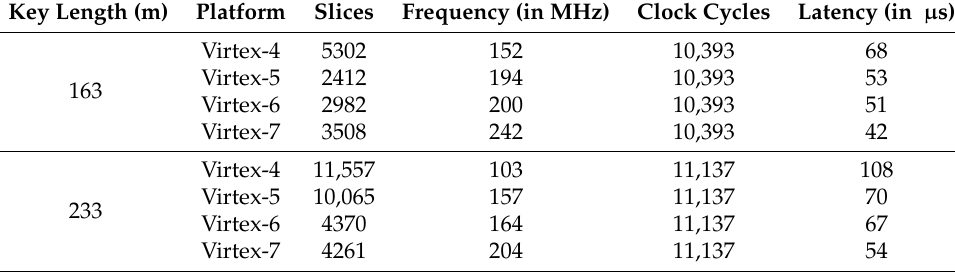
Table 4. Implementation results for GF ( 2 163 ) and GF ( 2 233 ) on Xilinx Virtex-4, 5, 6 and 7 FPGA devices. Key Length